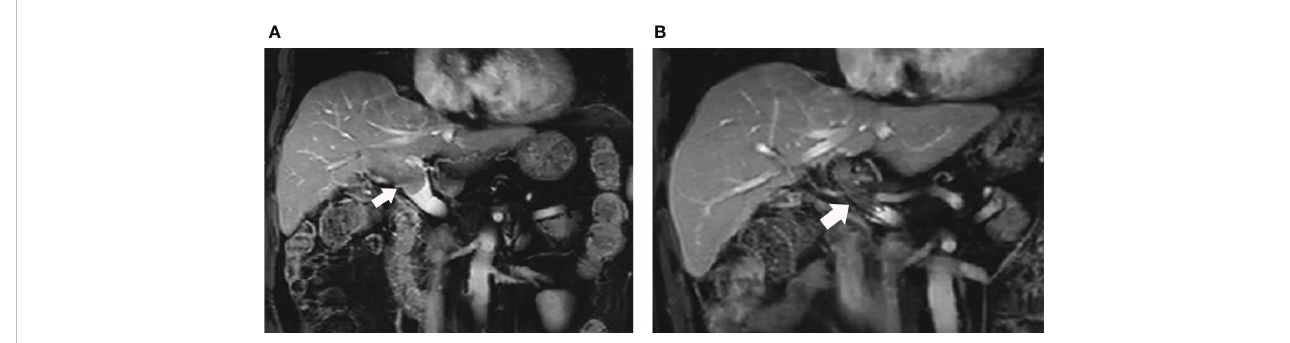
FIGURE 4 (A) The MRI images of this male patient shows the tumor thrombus had invaded into the MPV from right portal vein (white arrow); (B) The patient received 125 I seed strands and PVS implantation plus TACE combined with lenvatinib and anti-PD-1 antibody therapy. The MRI images performed 11 months after the initial procedure shows the stent is still patent (white